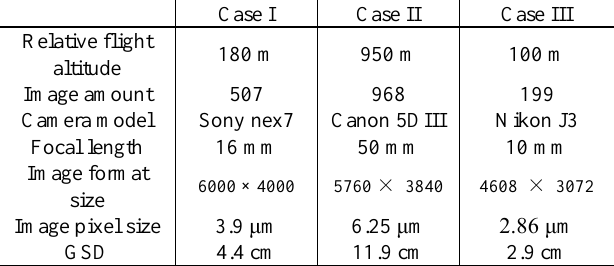
Table 1. Parameters of the experiments.